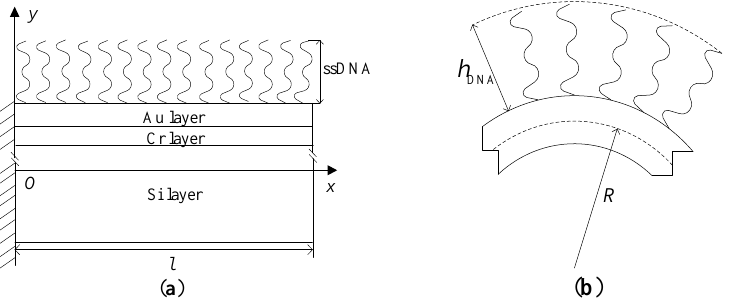
Figure 1. Schematic showing a DNA-microcantilever sensor and its coordinate system: ( a ) before deformation; ( b ) after deformation.